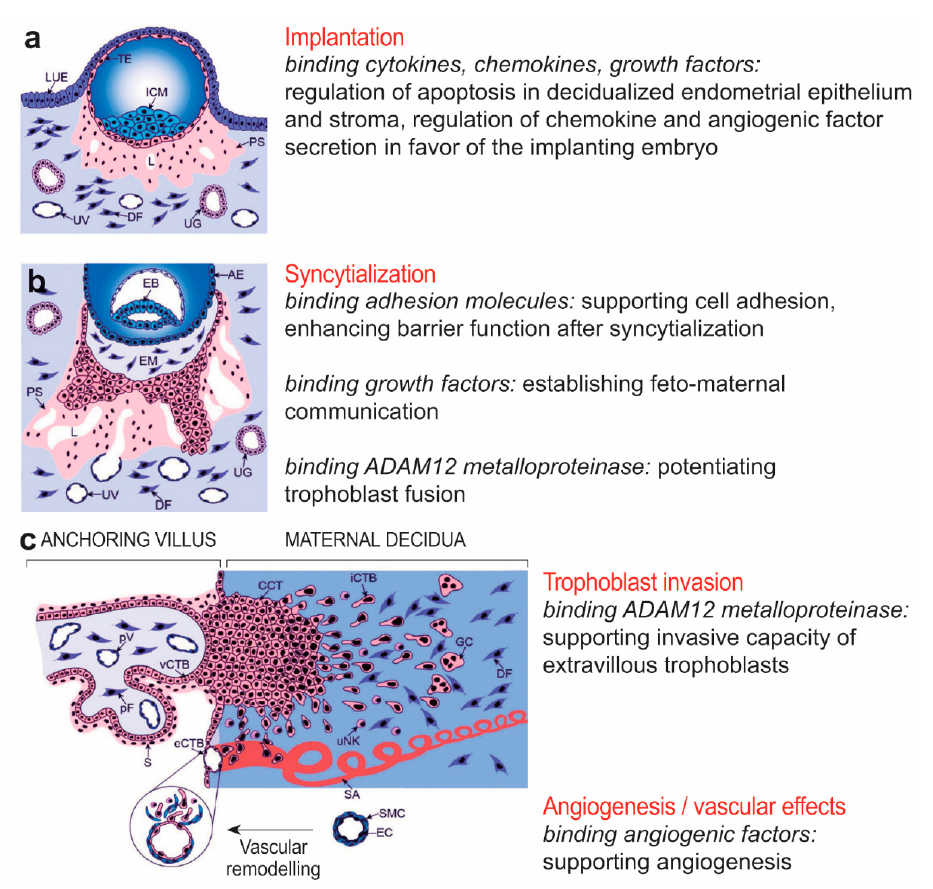
Figure 7. Physiological aspects of syndecan-1 at the maternal-fetal interface. The figure represents multiple roles of syndecan-1 in implantation, angiogenesis, maternal-fetal immune tolerance, and trophoblast invasion. ( a ) Embryo implantation. ( b ) Formation of primary villi by proliferative cytotrophoblasts and syncytialization. ( c ) Formation of tertiary villi, placental angiogenesis, extravillous trophoblast invasion, and spiral artery remodeling. Amniotic epithelium, AE; cell column trophoblast, CCT; dendritic cell, DC; decidual fibroblast, DF; embryoblast, EB; endothelial cell, EC; extracellular matrix, ECM; extraembryonic mesoderm, EM; endovascular cytotrophoblast, eCTB; giant cell, GC; inner cell mass, ICM; interstitial cytotrophoblast, iCTB; luminal uterine epithelium, LUE; lacunae, L; matrix metalloproteinase, MMP; natural killer, NK; placental fibroblast, pF; primitive syncytium, PS; placental vessel, pV; spiral artery, SA; syncytium, S; smooth muscle cell, SMC; trophectoderm, TE; uterine gland, UG; uterine NK cell, uNK; uterine vessel, UV; villous cytotrophoblast,